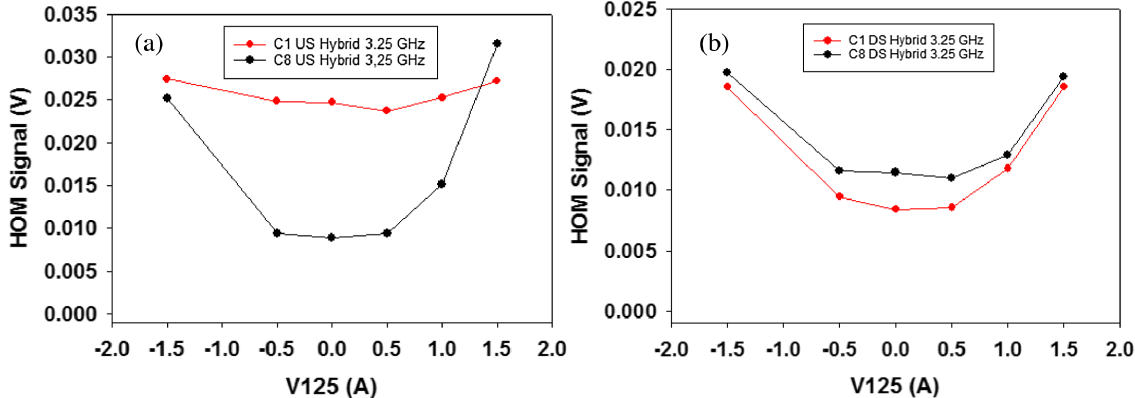
FIG. 18. A comparison of the 3.25-GHz signals in the (a) CM2:C1 US HOM (red data) and the C8 US HOM (black data) and (b) C1 DS and C8 DS during the V125 scan. The data exhibit a quadratic variation with beam offset symptomatic of a quadrupole field effect. The data are based on 300-shot